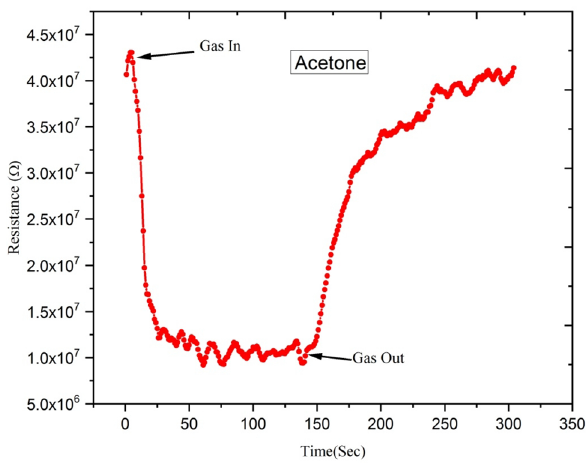
Figure 17. Variation of electrical resistance of Ga-doped ZnO thin film (Ag 9+ ion irradiated at 5 × 10 13 ion fluence) with time for acetone gas of 250 ppm concentration.